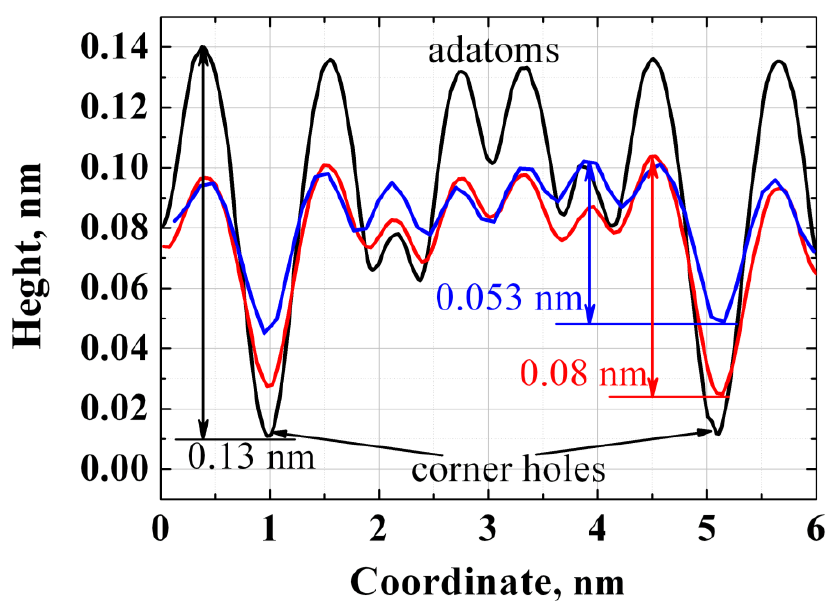
Figure 2. Comparison of height profiles along the lines indicated in Figure 1 as a function of scanning area. The blue curve is the profile in Figure 1a, the red one is the profile in Figure 1b and the black one is the profile in Figure 1c.